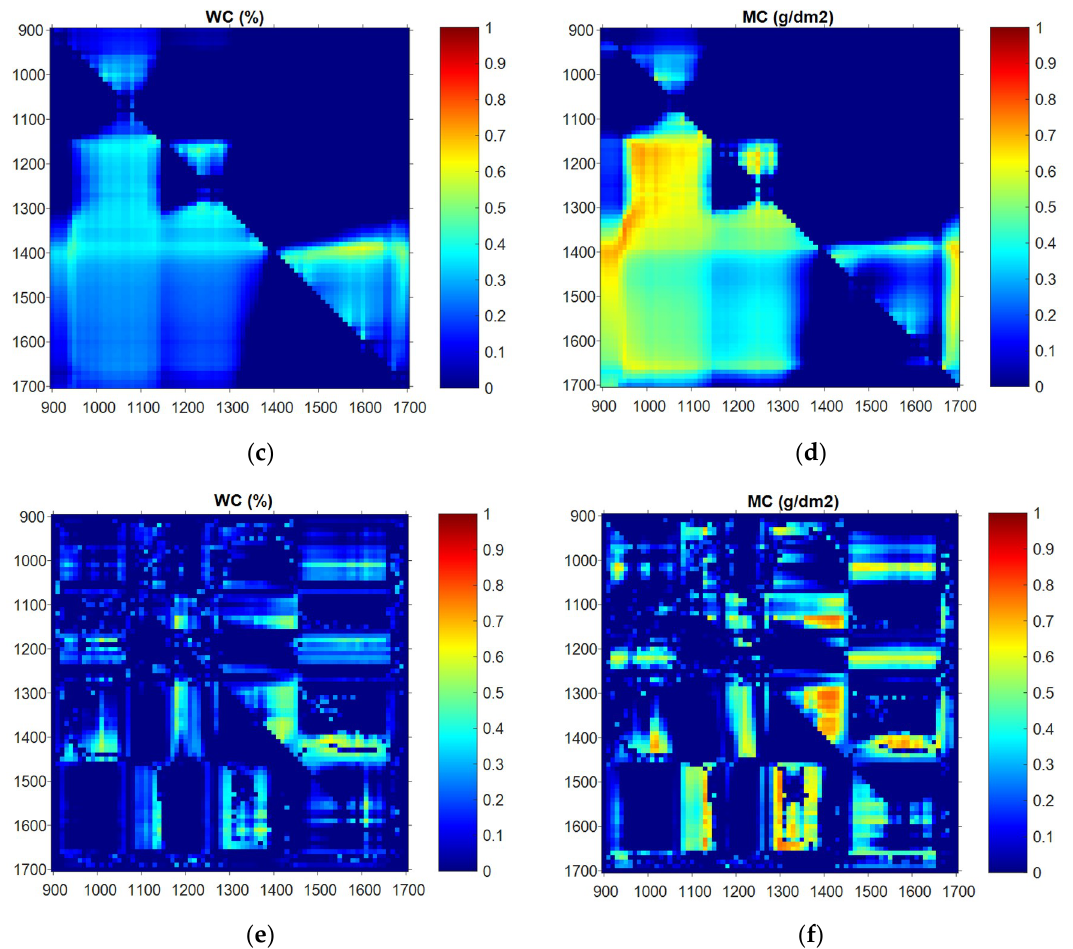
Figure 9. Normalized difference vegetation index (NDVI) of tomato wavelength and leaf water status. ( a ) RAW and WC; ( b ) RAW and MC; ( c ) LOG and WC; ( d ) LOG and MC; ( e ) DIFF and WC; ( f ) DIFF and MC. Appl. Sci. 2020 , 10 , x FOR PEER REVIEW 14 of 18